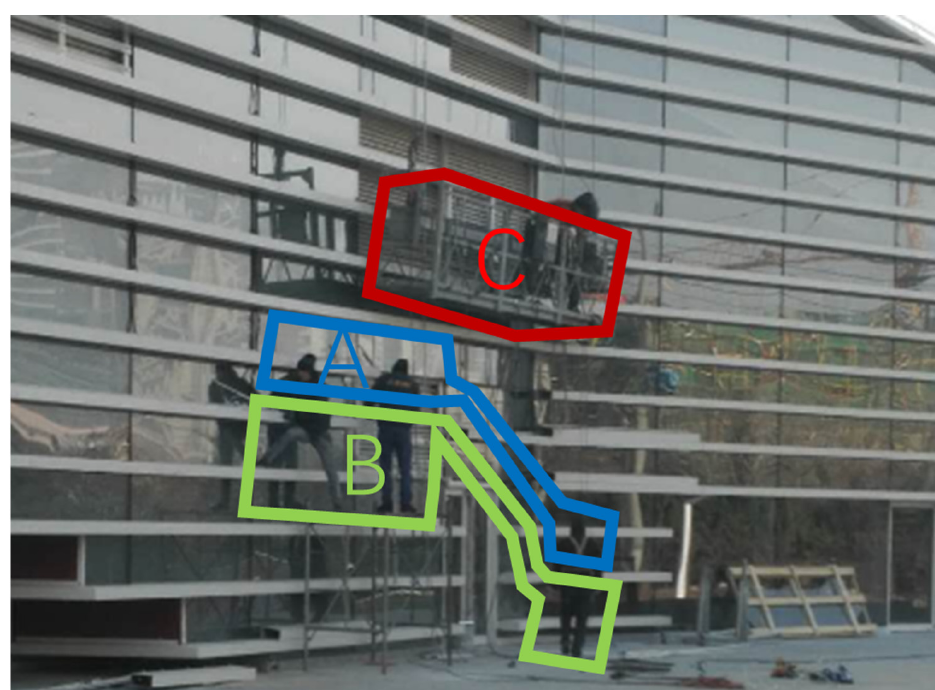
Figure 5. PPE failure (Hazard #2).